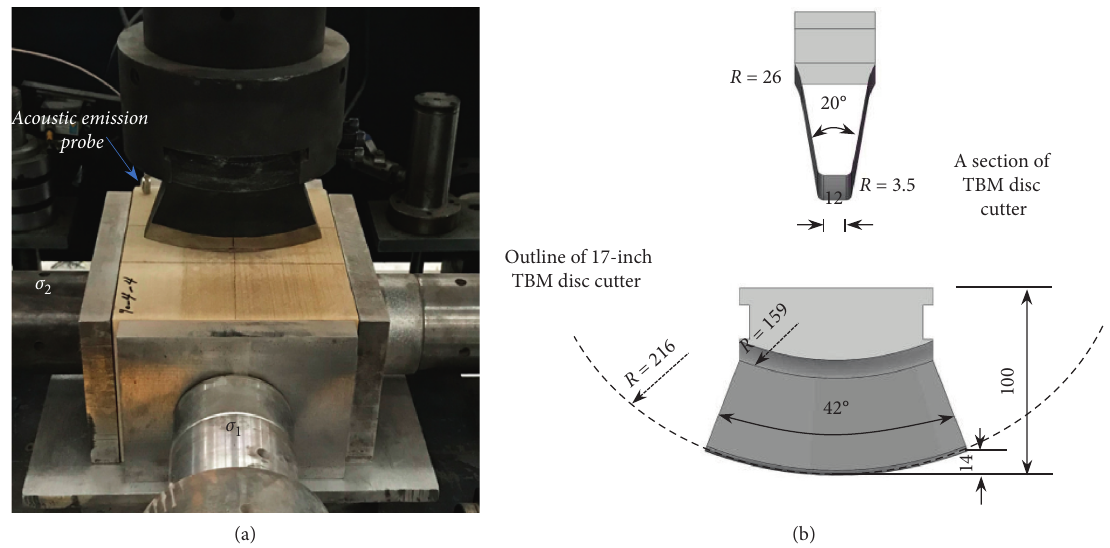
Figure 4: Testing system and geometry of penetration